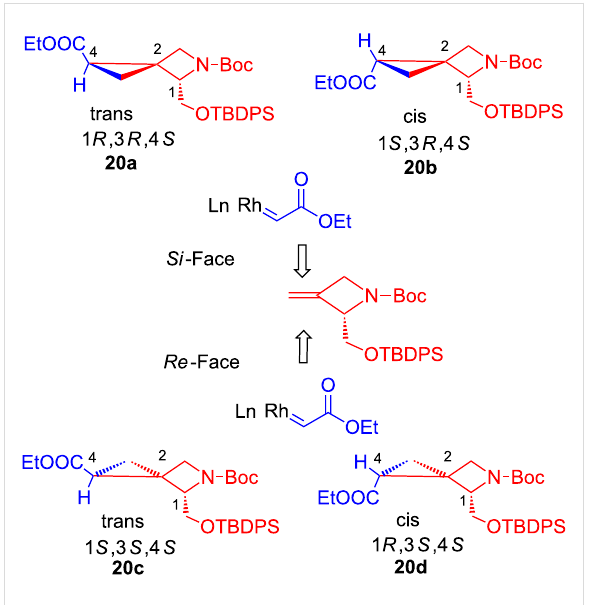
Figure 2: Mechanism for the attack of the carbene intermediate to the olefin moiety 18